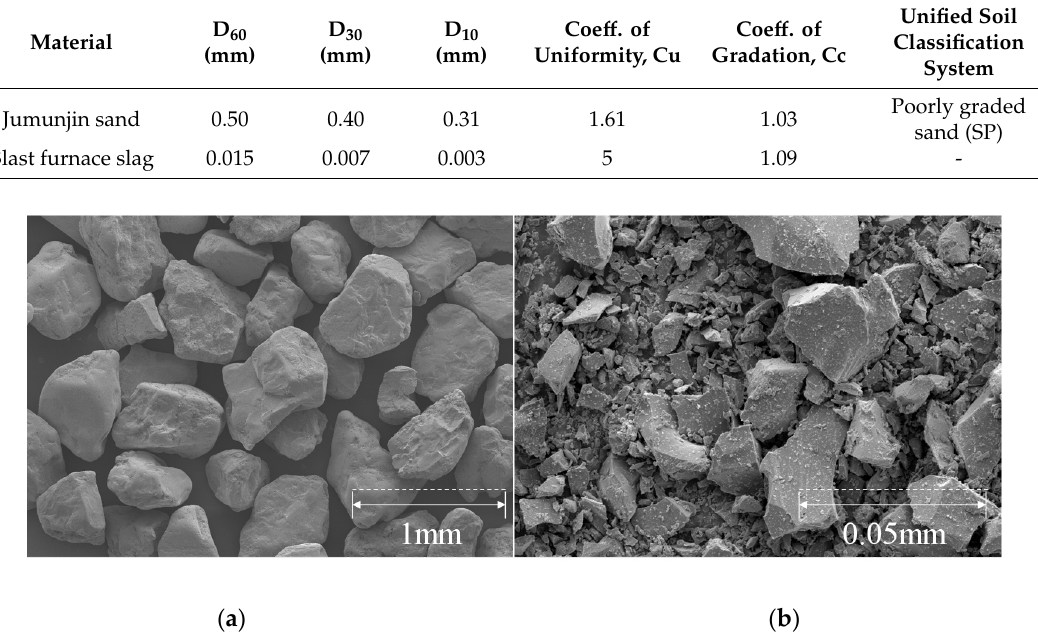
Figure 1. Grain size distribution curves of Jumunjin sand and blast furnace slag (BFS).